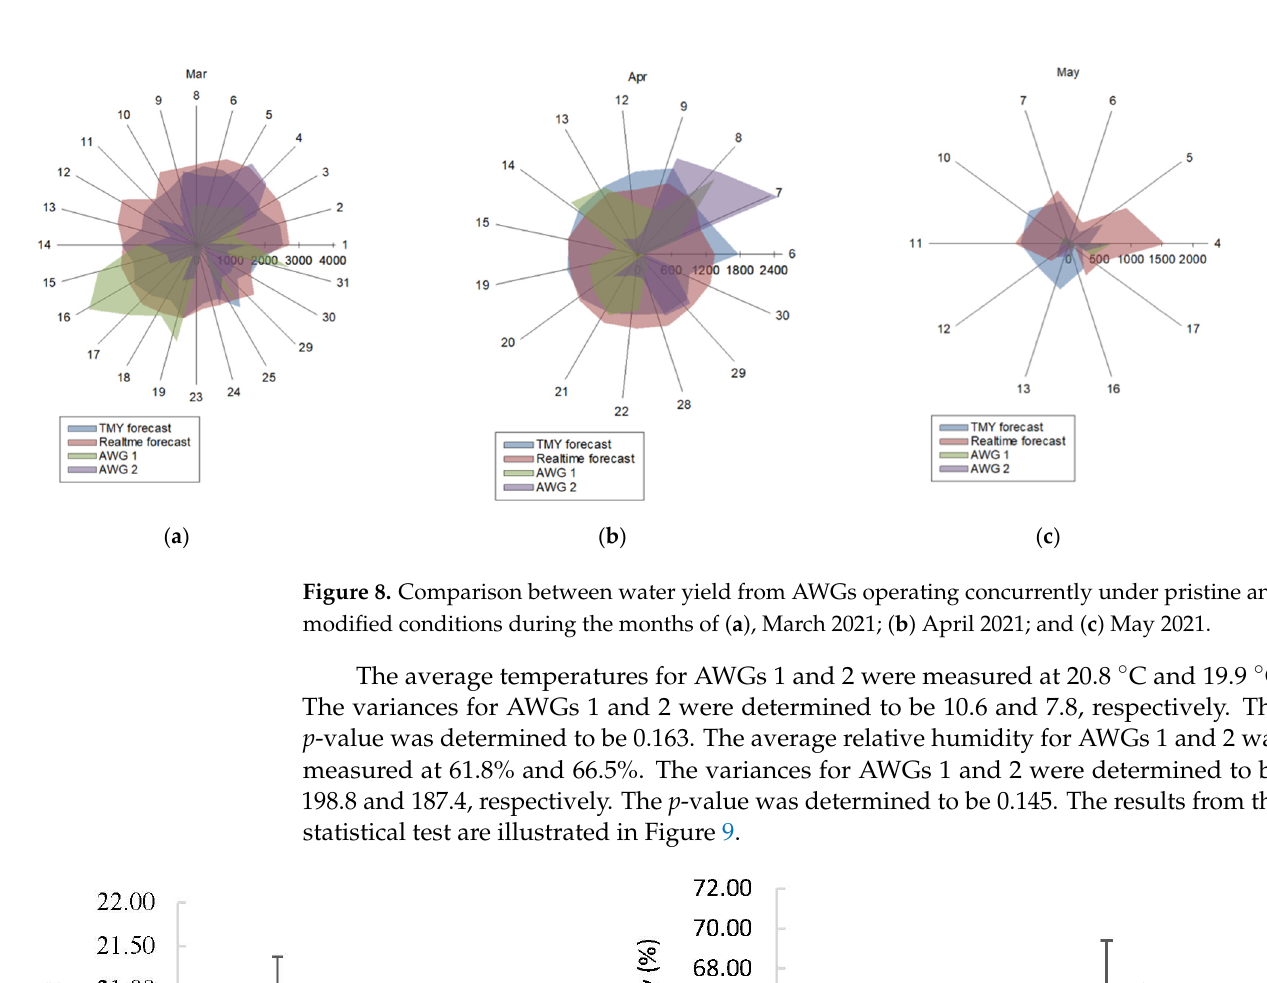
statistical test are illustrated in Figure 9.